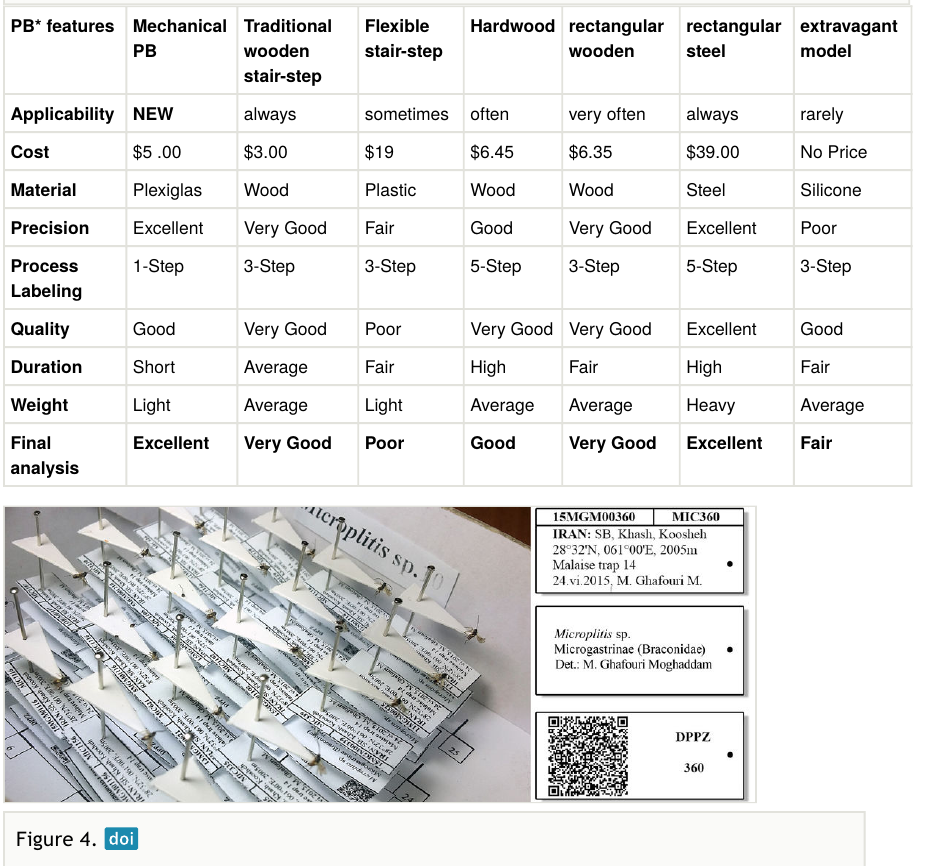
Figure 4. Specimens Microplitis sp. (Hymenoptera, Braconidae, Microgastrinae) arranged and labelled by upgraded pinning block in